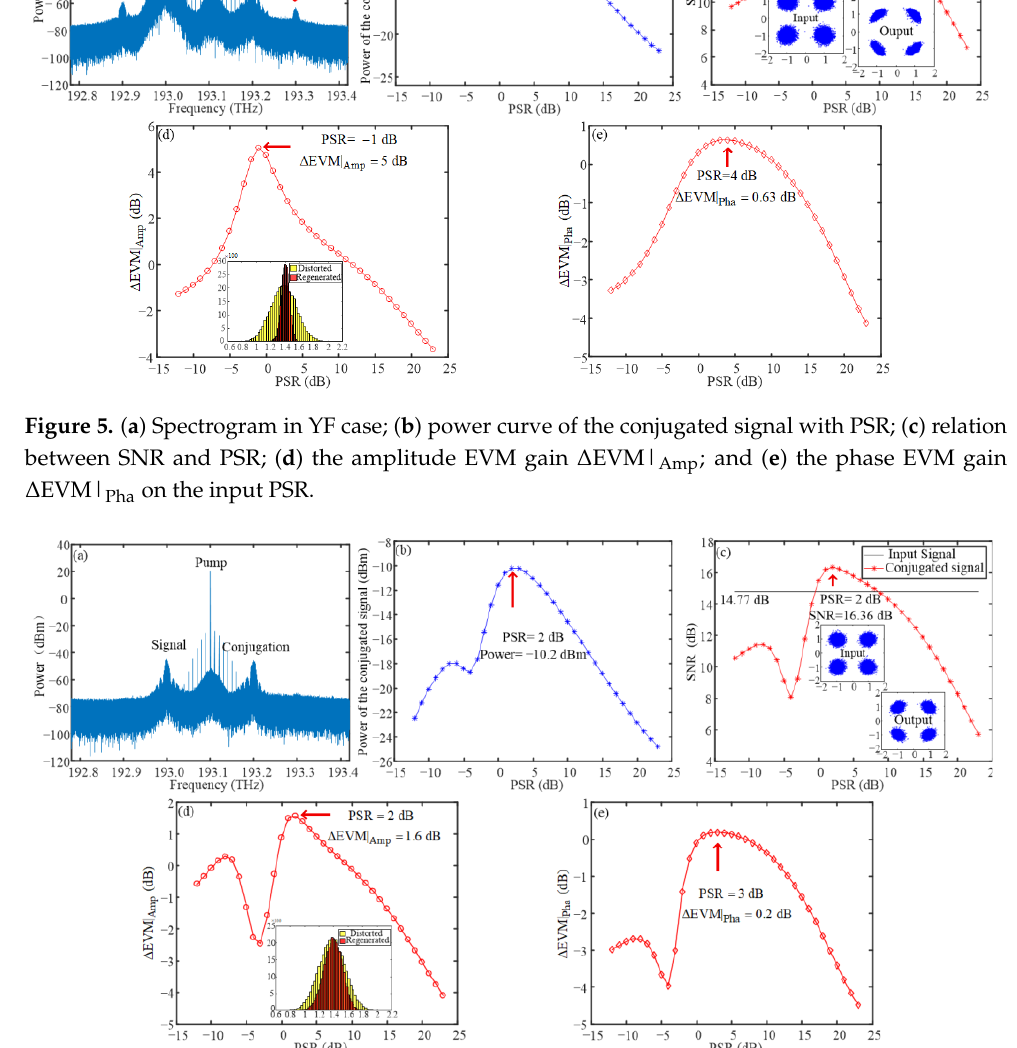
Figure 6. ( a ) Spectrogram in XB case; ( b ) power curve of the conjugated signal with (PSR); ( c ) rela- tion between SNR and PSR; ( d ) the amplitude EVM gain ΔEVM| Amp ; and ( e ) the phase EVM gain between SNR and PSR; ( d ) the amplitude EVM gain ∆ EVM| Amp ; and ( e ) the phase EVM gain ΔEVM| Pha on the input PSR. ∆ EVM| Pha on the input